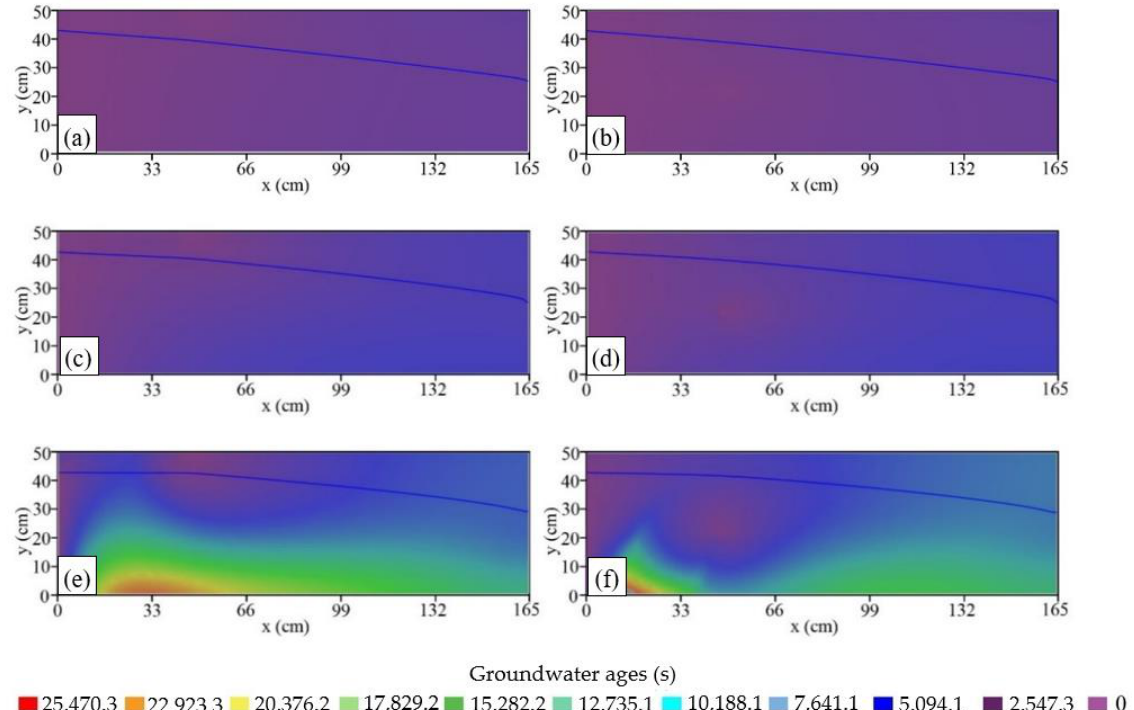
Figure 9. Groundwater age driven by depth-decaying hydraulic conductivity and artificial recharge through the infiltration basin (left side) and injection well IW3 (right side). The depth-decay exponents in ( a ) and ( b ) were set to 0.01 m −1 . The depth-decay exponents in ( c ) and ( d ) were set to 0.05 m −1 . The depth-decay exponents in ( e ) and ( f ) were set to 0.1 m −1 . The blue lines in the figures represent the water table.